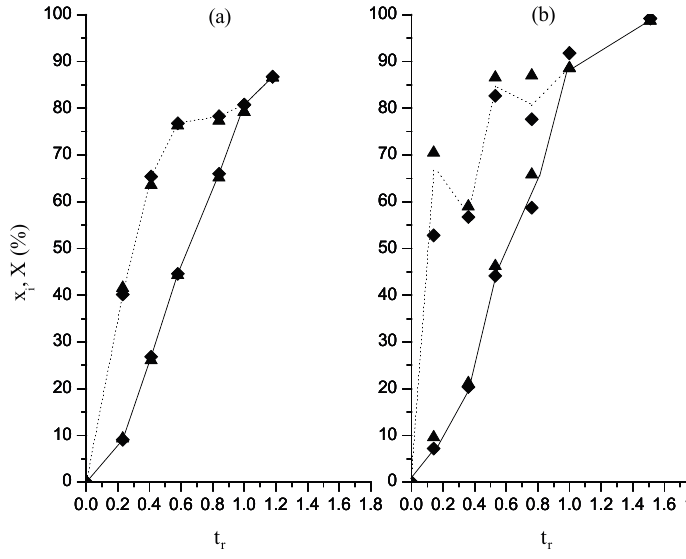
Figure 1. Evolution of instantaneous, x i (----) and global, X ( ― ) conversions with relative time in polymerizations at 0.05 ( a ) and 0.15 ( b ) g/min in organic phase dosing rate. Runs M ( ♦ ); runs MR ( ▲